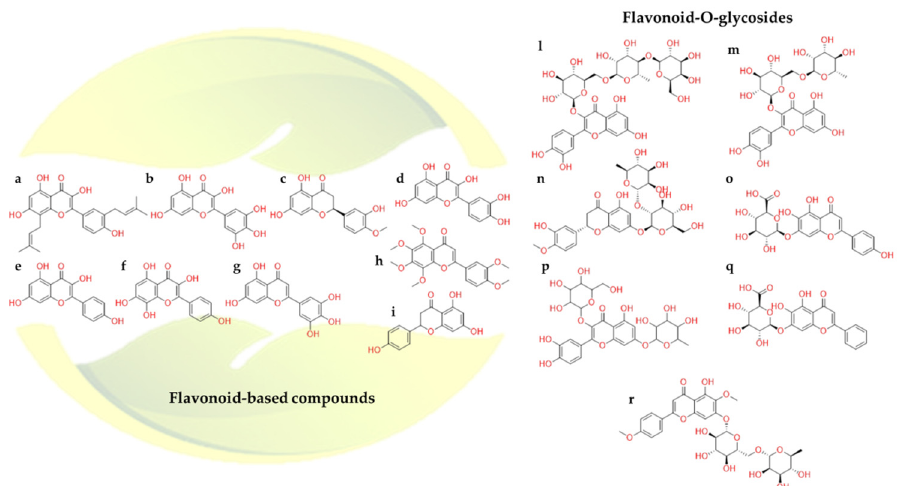
Figure 17. 2D structures of ( a ) broussoflavonol F, ( b ) myricetin, ( c ) hesperetin, ( d ) quercetin, ( e ) kaempferol, ( f ) herbacetin, ( g ) tricetin, ( h ) nobiletin, ( i ) naringenin, ( l ) quercetin-3- O -galactosyl- rhamnosyl-glucoside, ( m ) rutin, ( n ) neohesperidin, ( o ) scutellarin, ( p ) quercetin-3- β -galactoside, ( q ) baicalin, ( r ) pectolinarin.